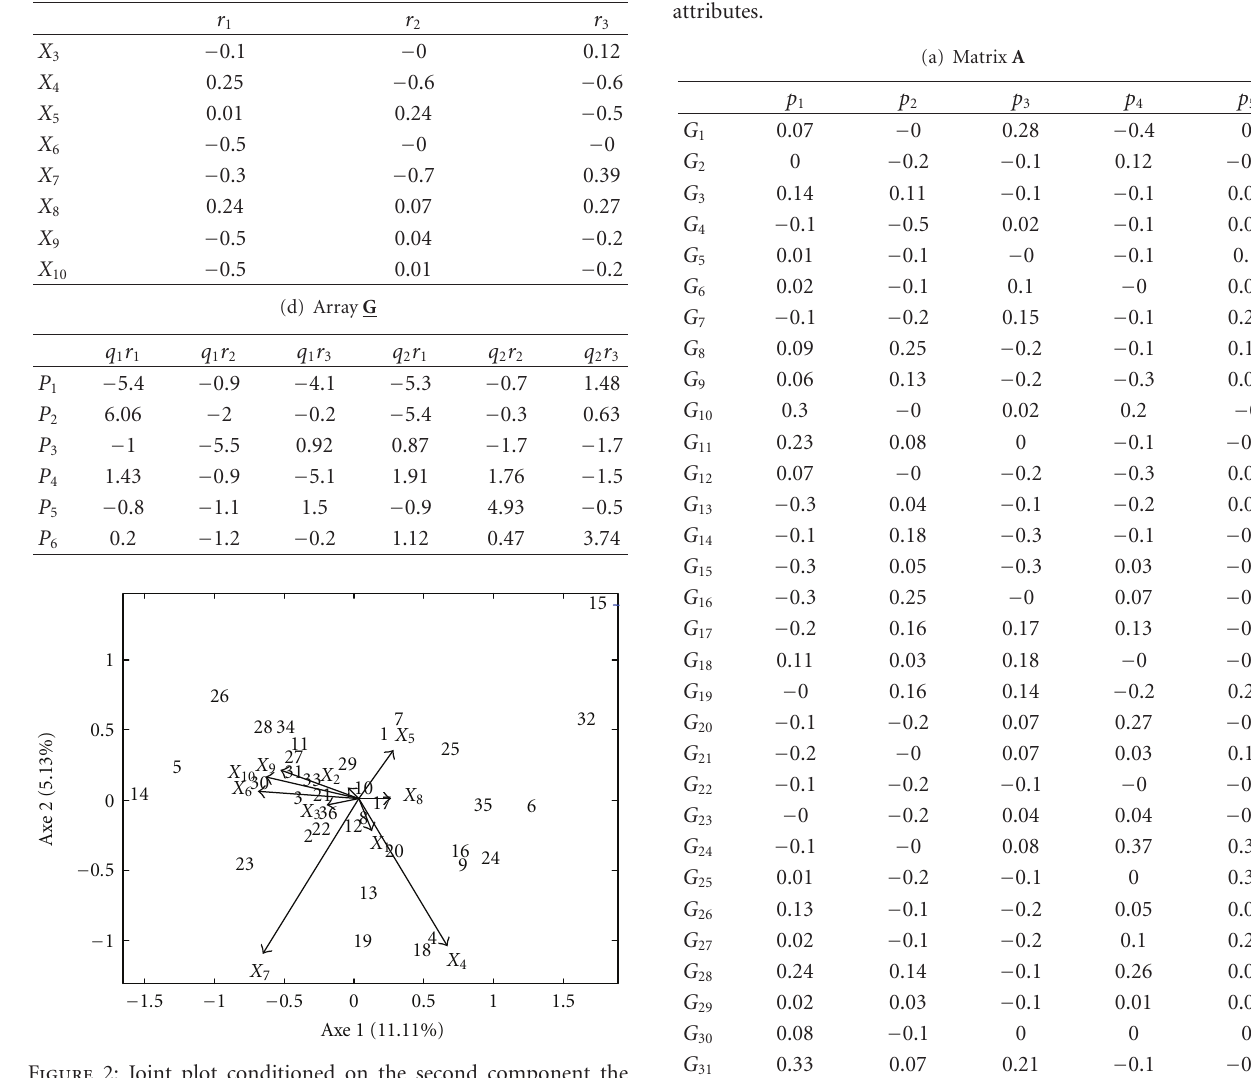
Figure 2: Joint plot conditioned on the second component the location mode for AMMI model.